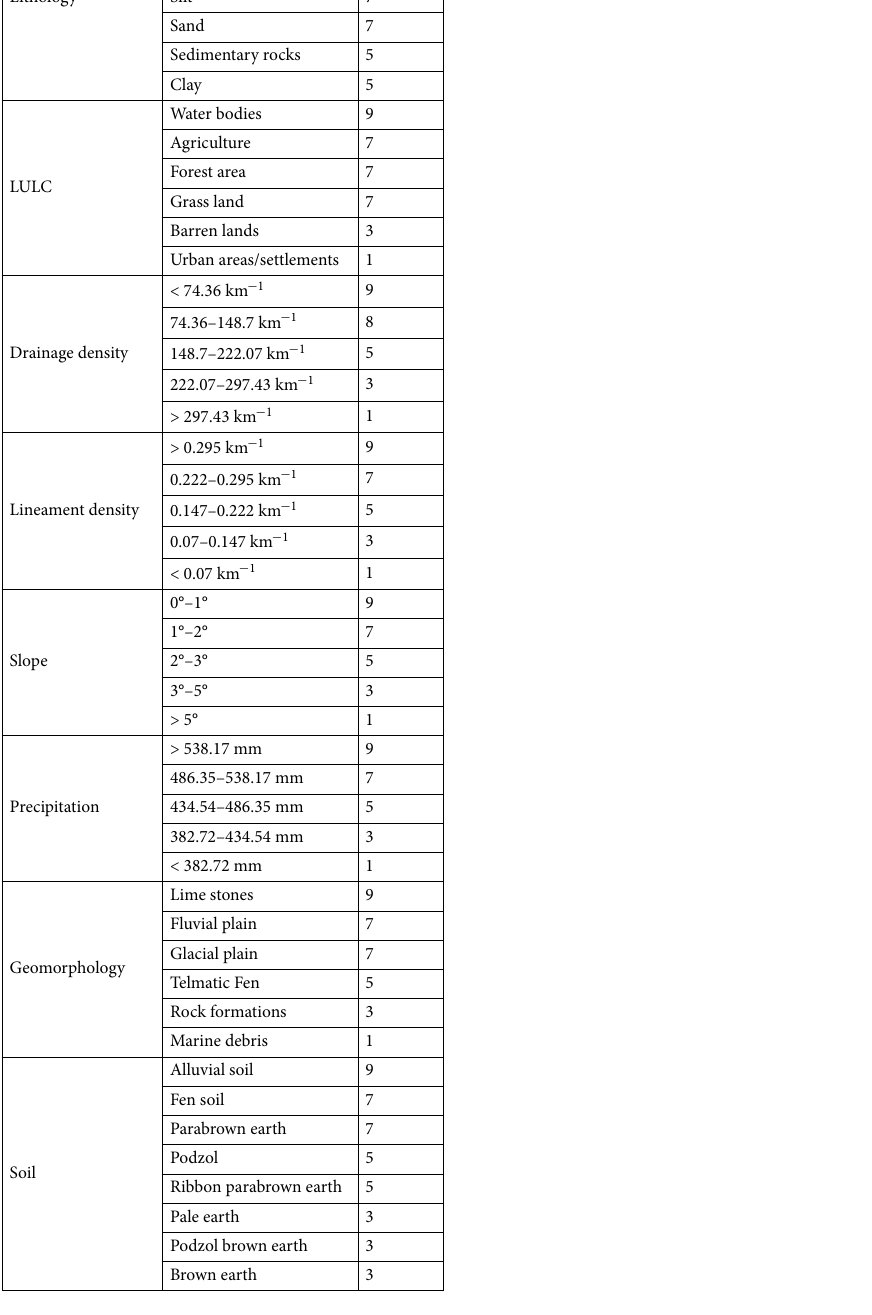
Table 4. Prioritizing sub layers for